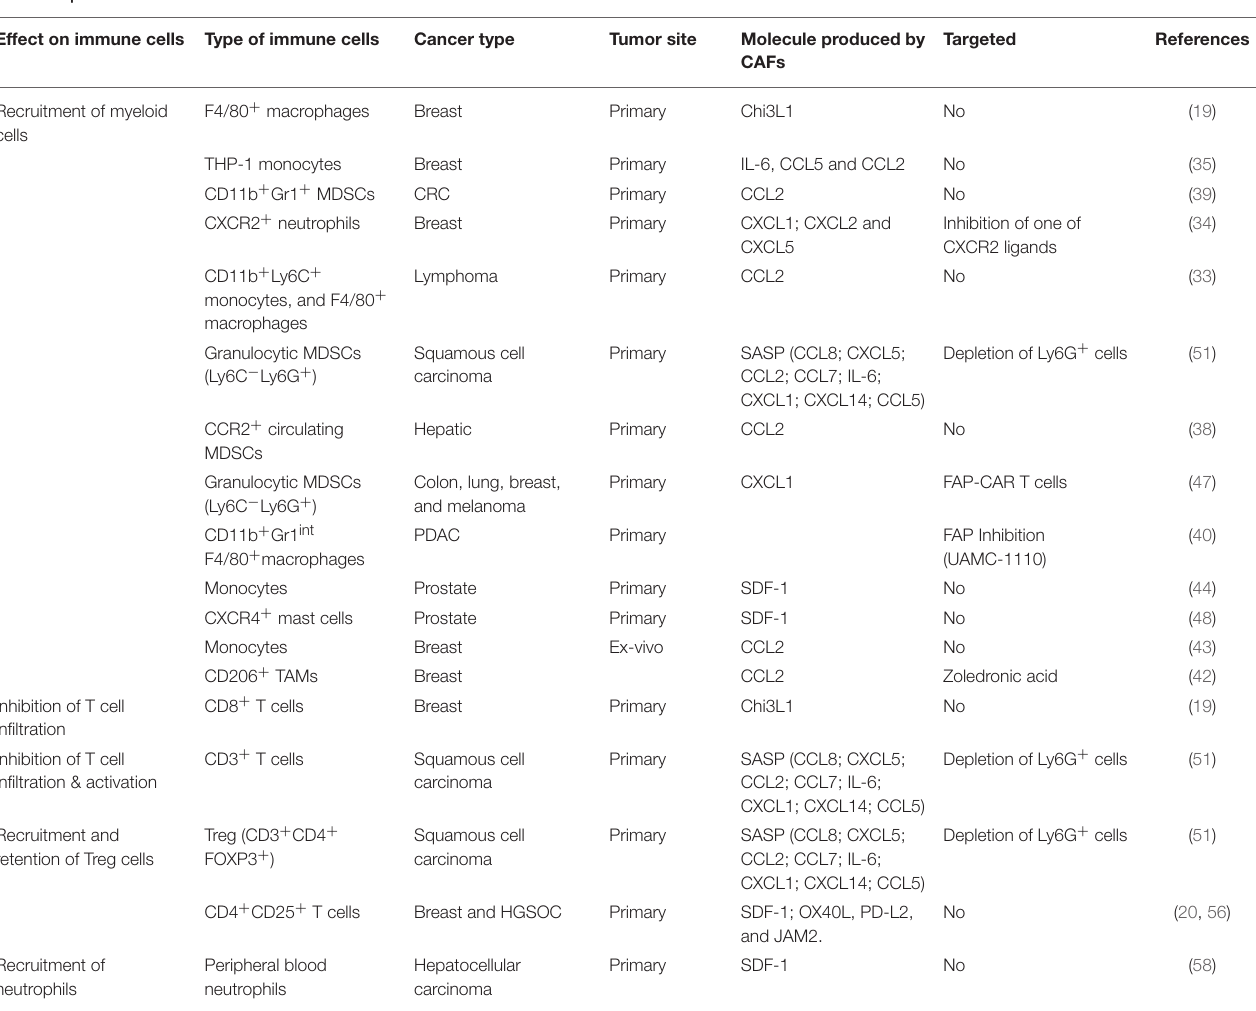
TABLE 1 | Recruitment or exclusion of immune